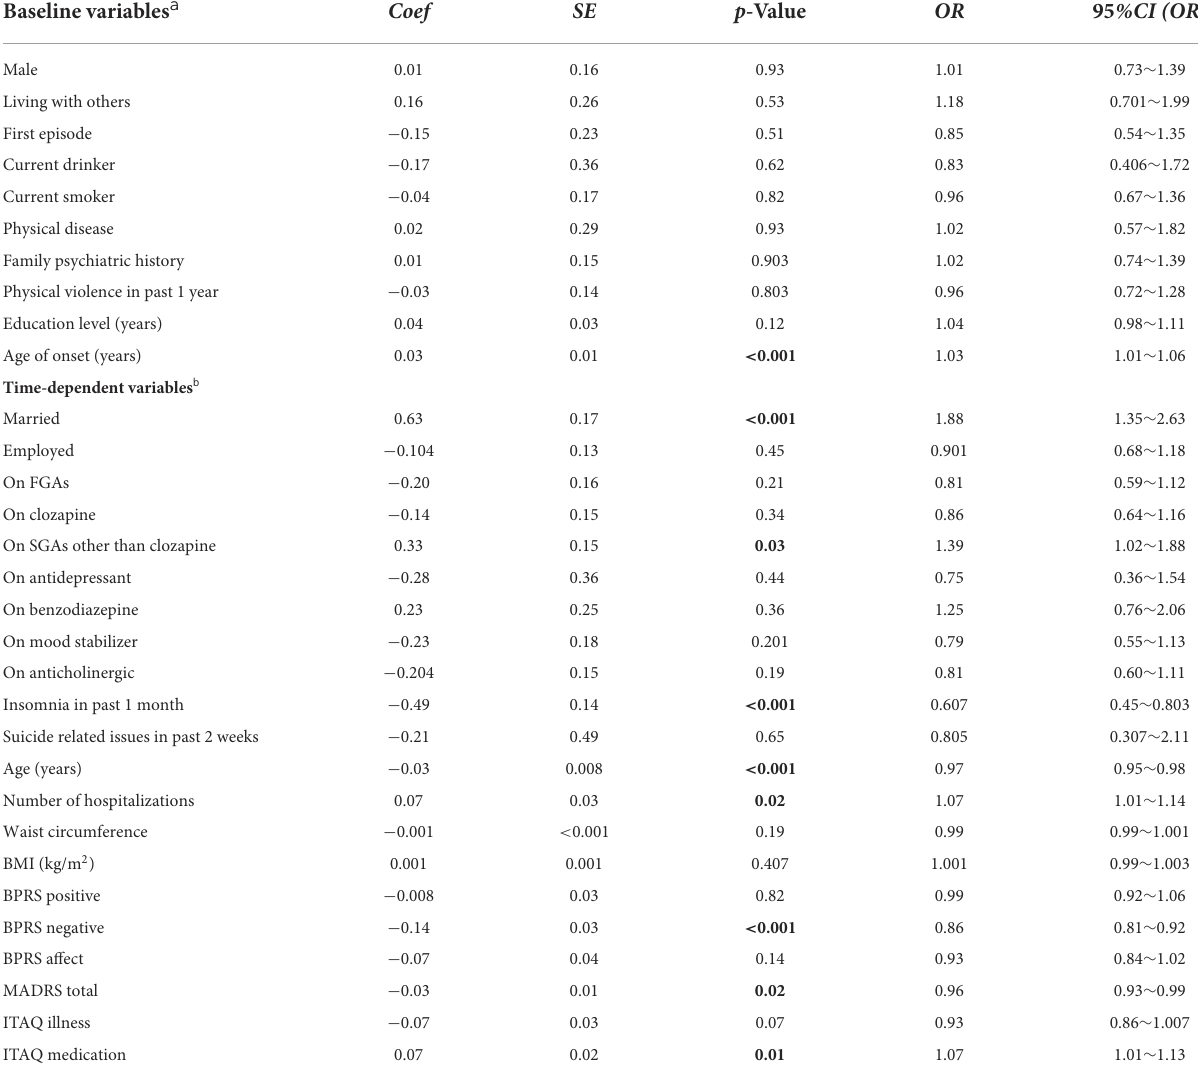
TABLE 6 Generalized Estimating Equations (GEE) results modeling risk factors associated with WHOQOL Social Relationship domain in 491 patients with schizophrenia. Baseline variables